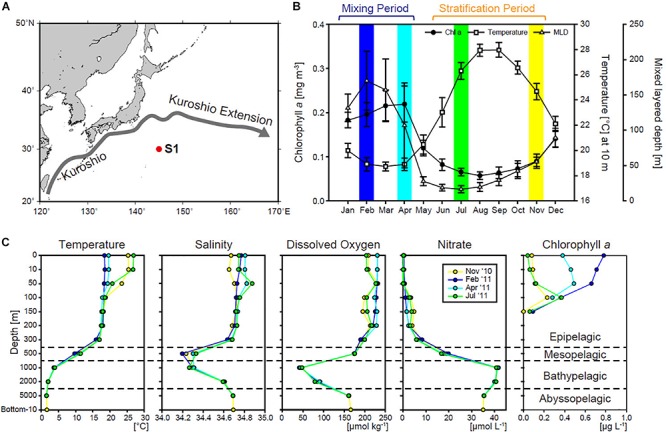
(A) Location of station S1 in the northwestern North Pacific Ocean. (B) Seasonal variations in satellite-derived (MODIS Aqua) chlorophyll a (chl a), sea surface temperature, and Argo-derived mixed layer depth (MLD) (Hosoda et al., 2010) at station S1 (1° × 1° area), averaged between January 2003 and December 2012. Colored bars indicate the months in which the cruises took place. (C) Vertical profiles of temperature, salinity, dissolved oxygen, nitrate, and chl a during each cruise.